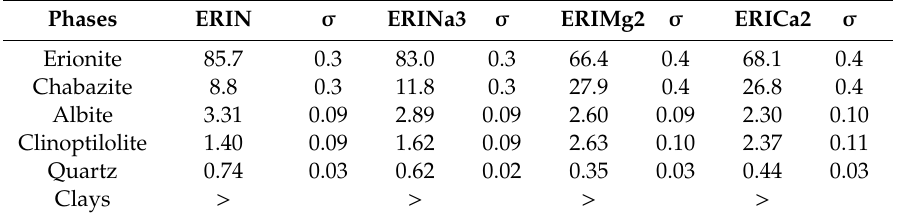
Table 2. QPA of the various samples. Clays were observed in all samples but were not quantified owing to the absence of an adequate structural model (see text). The content has been estimated to be similar in all samples and < 5 wt.% from visual evaluation of the intensity of the relevant reflections.